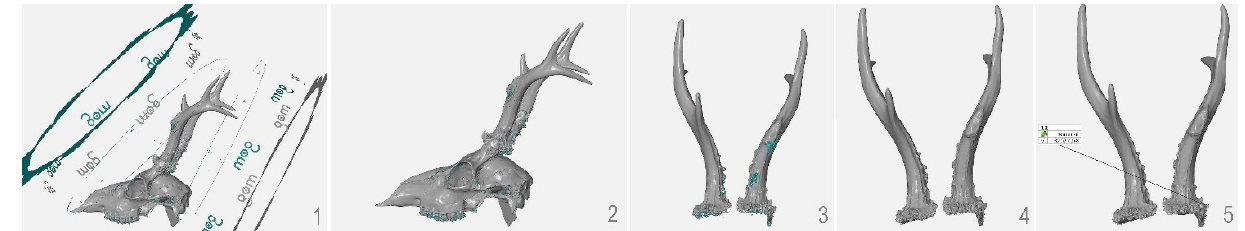
Figure 3. Process of object modification before measurement. 1. digitized object without modification (with unwanted parts of the turntable around the object); 2. mesh object after cleaning; 3. mesh object to be measured; 4. mesh object with filled holes, ready for measurement; 5. mesh object with the volume measurement results.